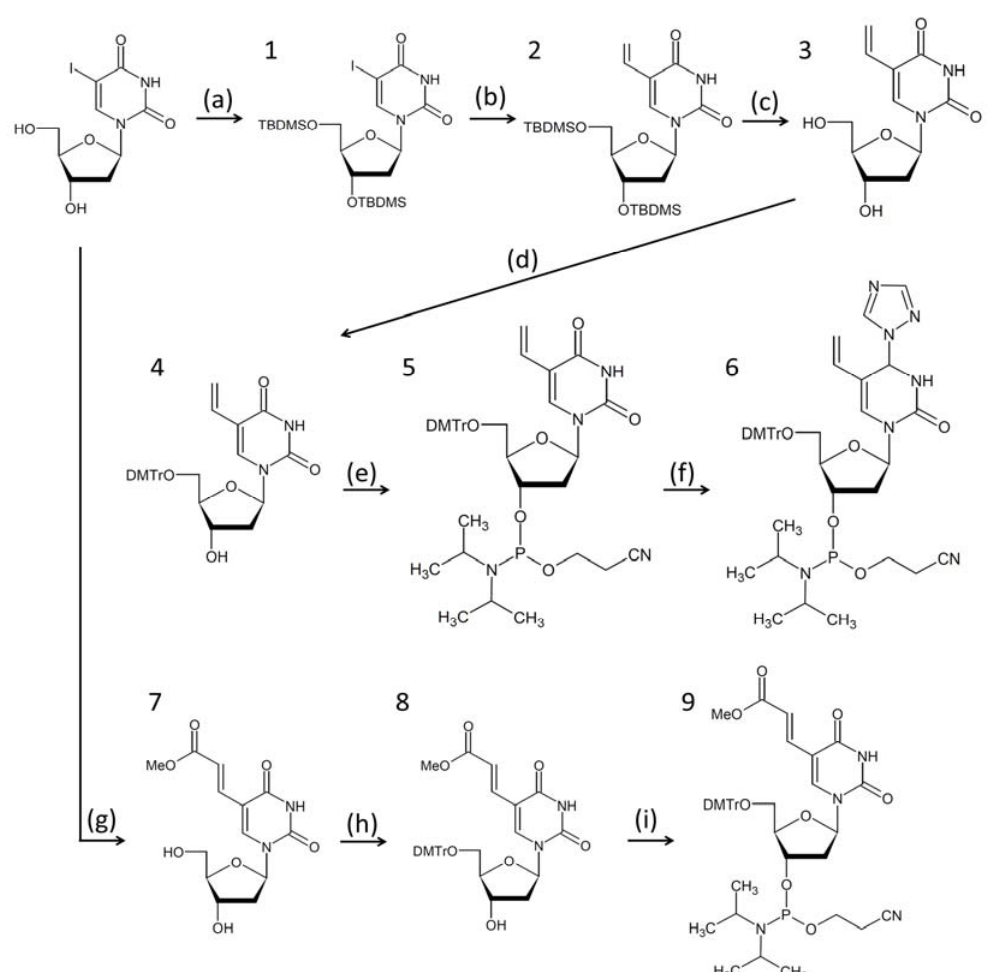
Scheme 2. Synthetic scheme of photoresponsive